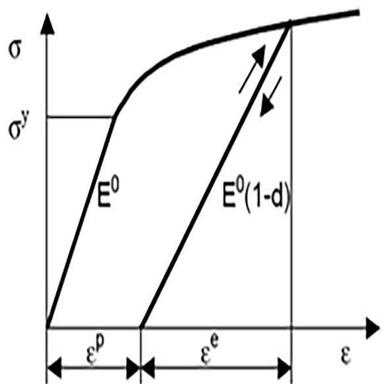
Theoretical inelastic stress/strain response of damaged composites. Reproduced from .